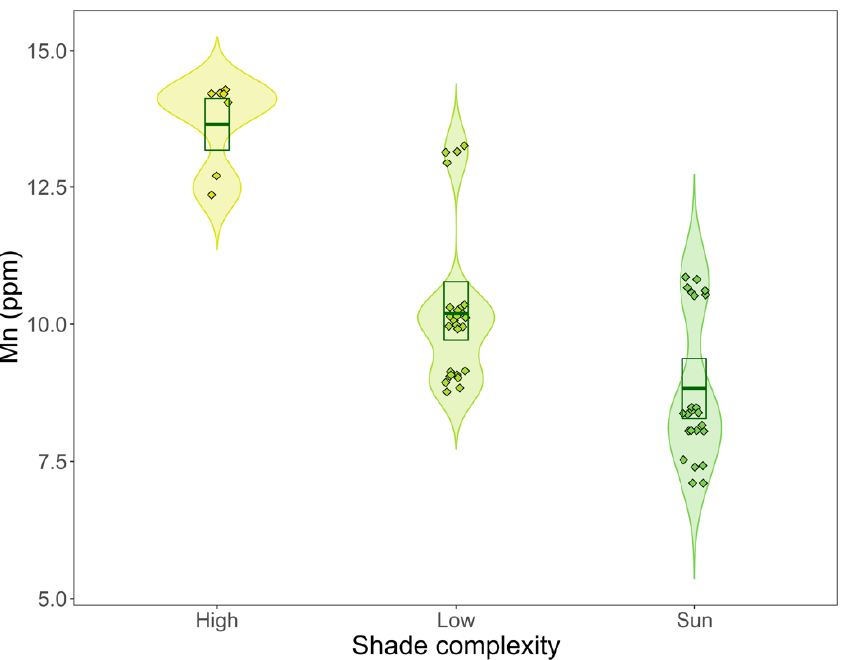
Figure 5. Mn concentration of soil samples from 56 coffee home gardens in West Java in relation to shade complexity of gardens (High: >10% shade cover and ≥ 5 shade tree species; Low: >10% cover and <5 shade tree species; Sun: <10% shade cover). Data are model predicted values from generalised linear models, and boxes dictate 95% confidence intervals.